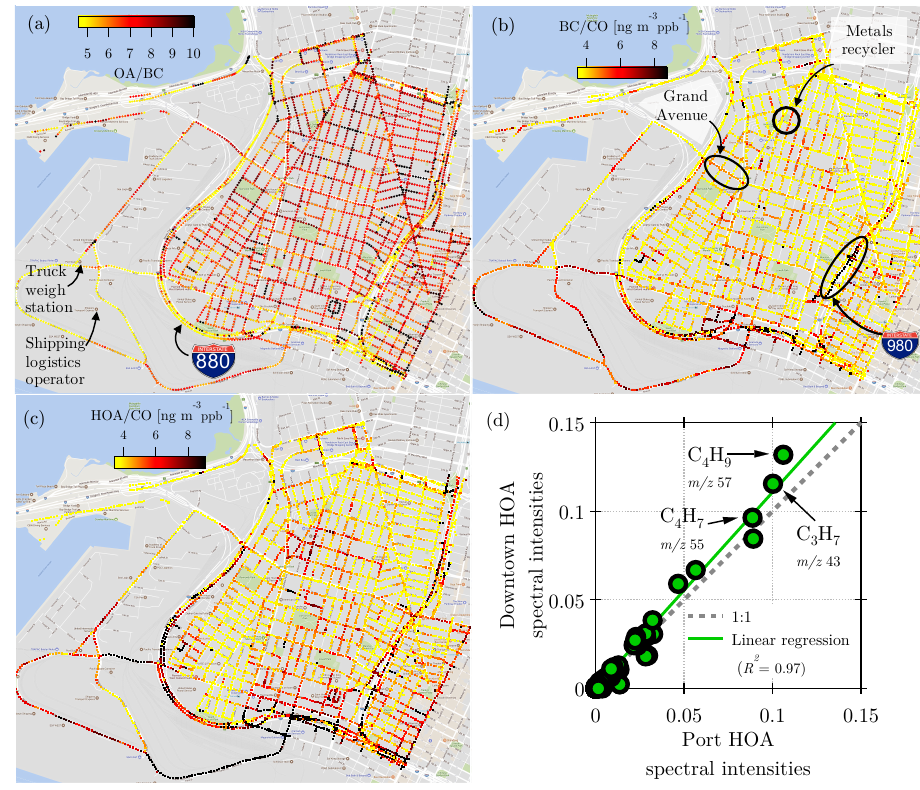
Figure 9. Fine-scale maps of (a) OA / BC (unitless), (b) BC / CO, and (c) HOA / CO. Panel (d) shows similarity between the HOA factors identified by factorization of port-only and downtown-only OA data. The two spectra are dominated by hydrocarbons (C x H y ) and are highly similar to each